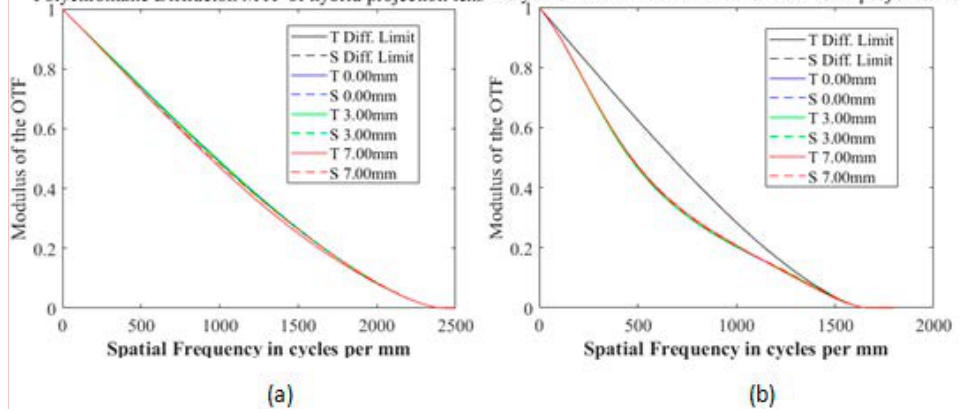
Figure 9. The MTF curves of different fields of view for hybrid ( a ) and traditional ( b ) projection lens systems.